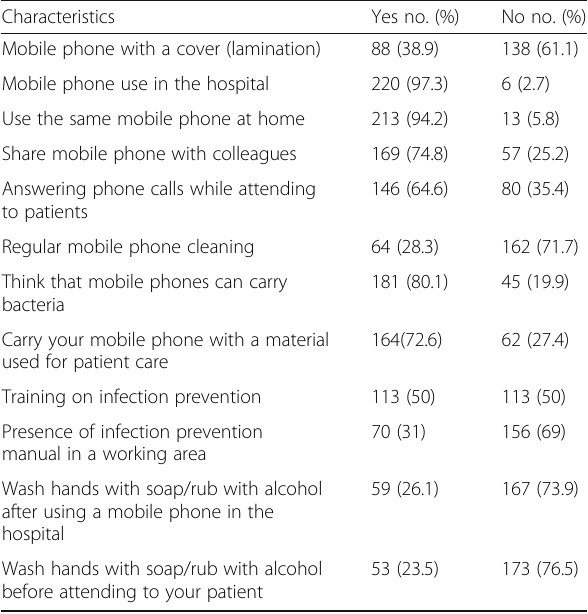
Table 2 Characteristics on the use of mobile phones